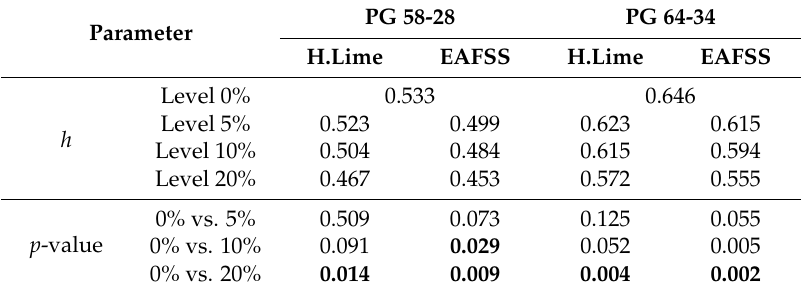
Table 4. Huet Model Parameters h : statistical comparison for PG 58-28 and PG 64-34